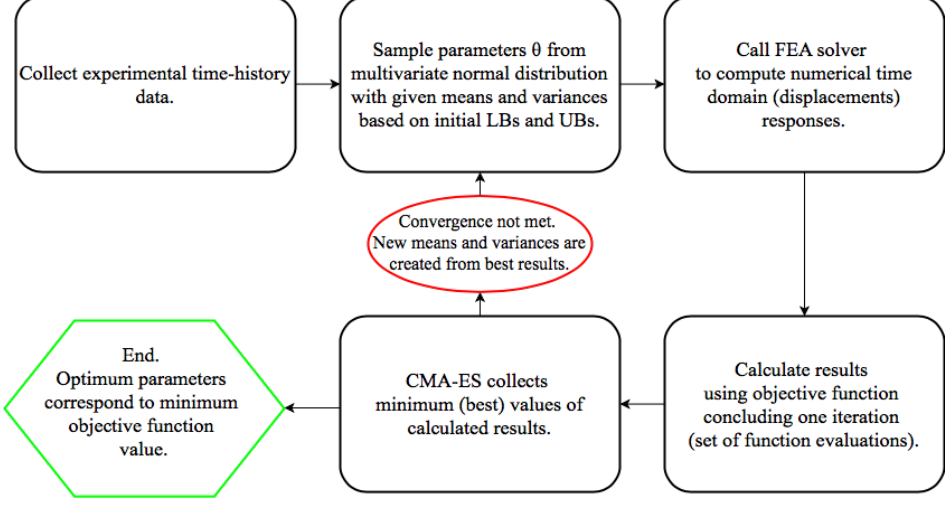
Figure 1. Flow diagram of the applied CMA-ES framework.